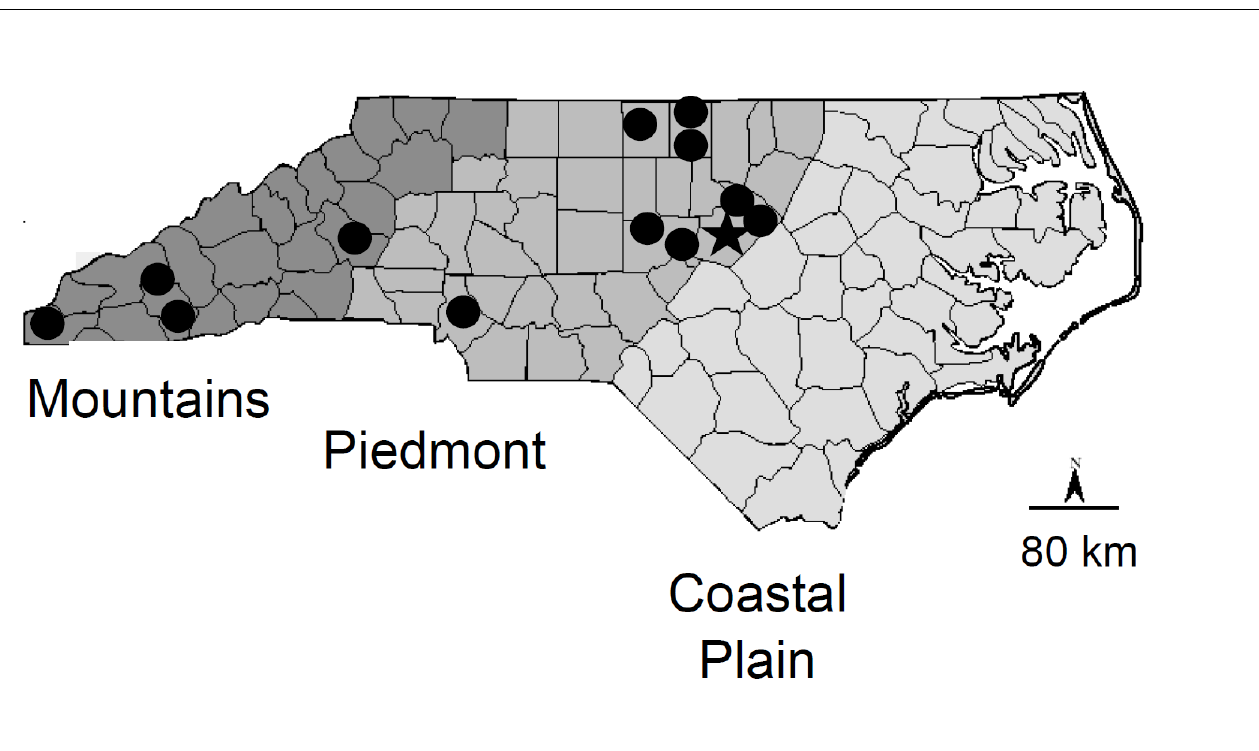
Figure 1. Map of North Carolina (N.C.) showing locations of sites sampled across the Mountain and Piedmont physiographic regions. Star indicates Raleigh, the capital city of N.C.